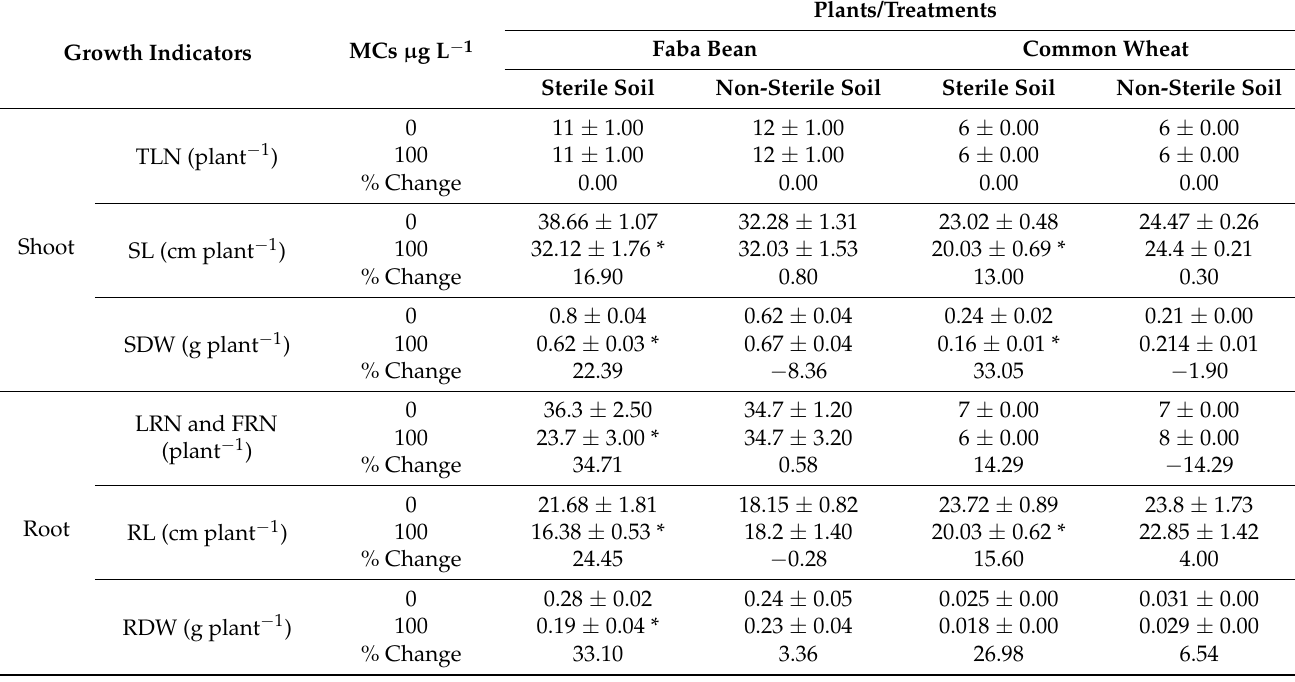
Table 2. Growth indicators of faba bean ( V. faba L., var. Alfia 321 ) and common wheat ( T. aestivum L., var. Achtar ) grown in sterile and non-sterile soils after 30-days exposure to MCs. Data are shown as mean ± standard deviation ( n = 10); mean values are significantly different ( p < 0.05) between the control (0 MCs µ g L − 1 ) and the treatment (100 MCs µ g L − 1 ) groups when indicated by